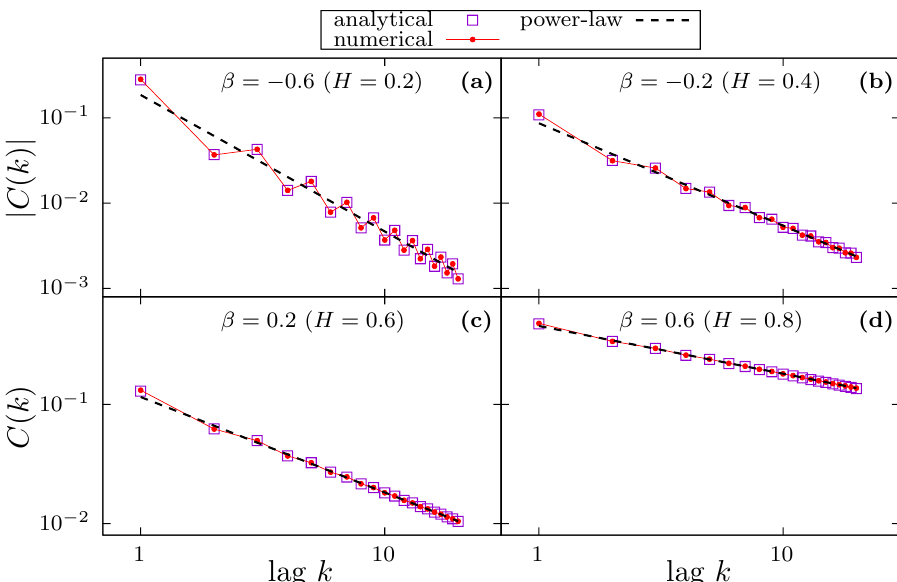
Figure 2. Autocorrelation function of 1/ f β noises with different β values: 0.6 ( a ), 0.2 ( b ), 0.2 ( c ), − − C ( k ) and 0.6 ( d ). For β = 0.6 and 0.2 (negative C ( k ) ), we plot to use logarithmic scales in both − − | | axes. In all panels, small connected circles correspond to the numerical C ( k ) obtained for synthetic FFM time series with N = 2 22 , squares correspond to the analytical solution in Equation (15), and the dashed lines correspond to the asymptotic power-law behavior (first term of Equation